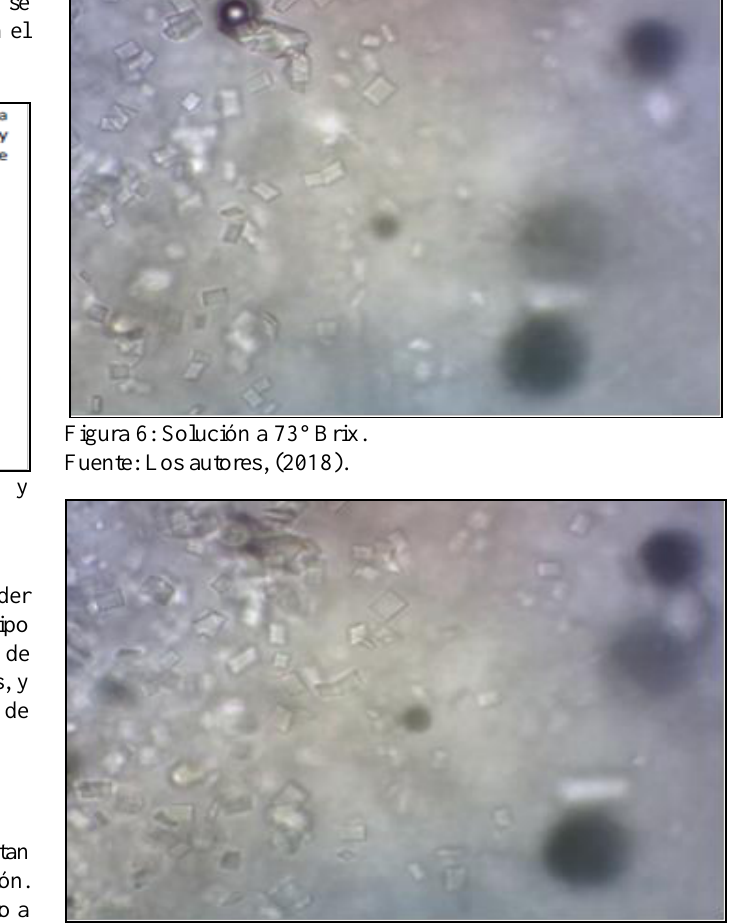
Figura 7: Solución a 80° Brix. Fuente: Los autores,